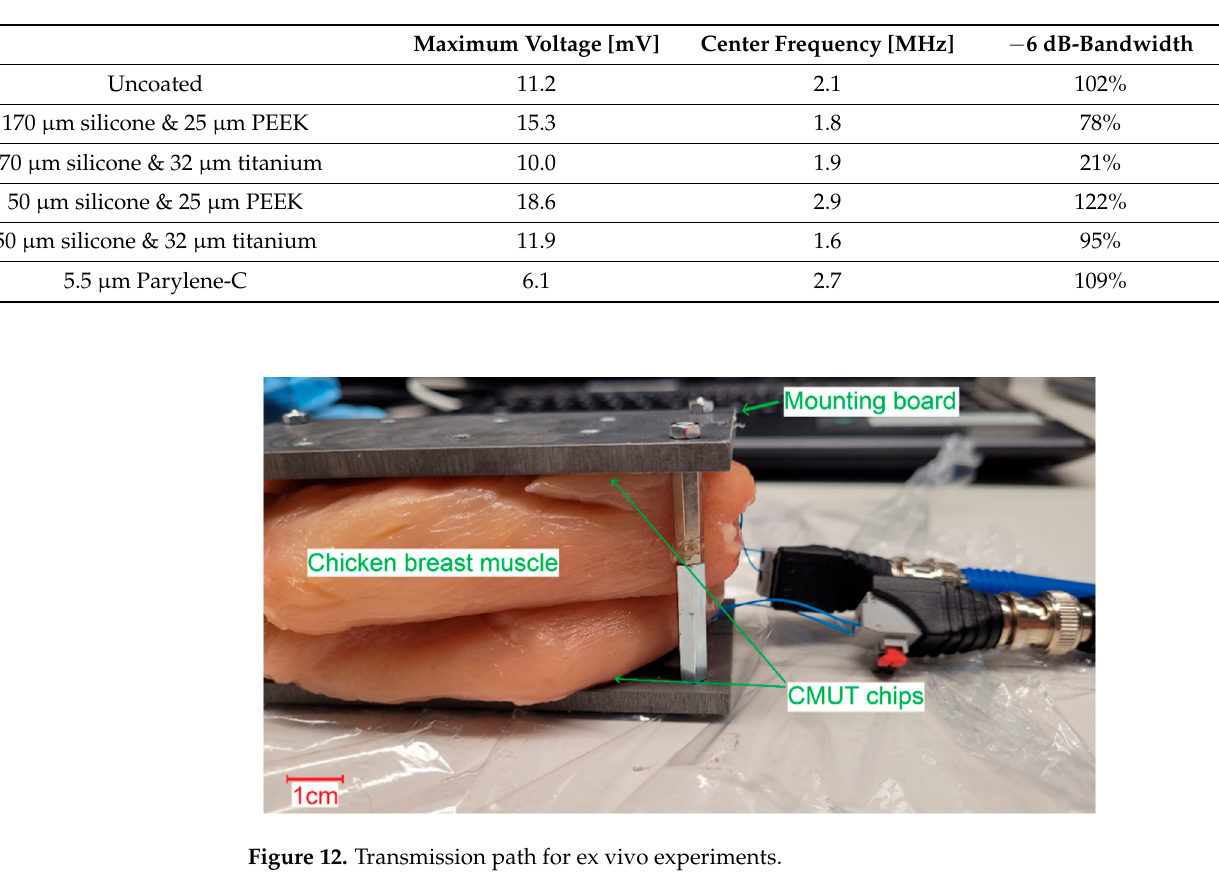
Table 2. Results from the transmit experiments in Fluorinert for different encapsulations 60 V DC , 10 V AC , burst count 20, distance 83 mm.